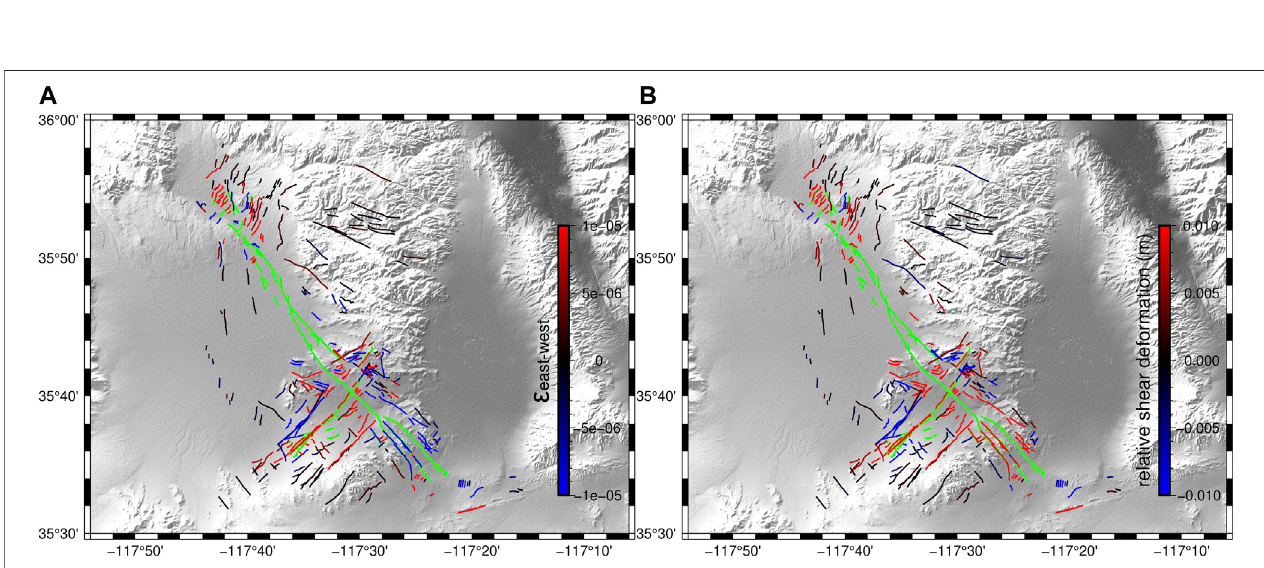
FIGURE5| Surfacedeformationpatternsacrosssmallfractures. (A) Colorsdenotetheeast – weststrainacrossfractures.Bluelinesindicatefractureslocatedinthe compressionalstrainregime,andredlinesindicatefractureslocatedinthetensionalstrainregimealongtheeast – westdirection.Blacklinesrepresentfractureswithsmall east – west strain. (B) Colors represent the shear deformation across fractures. Red lines indicate the left-lateral motion, and blue lines represent the right-lateral motion. Black lines show fractures with little shear motion, i.e., the shear motion difference across the fracture is close to zero.